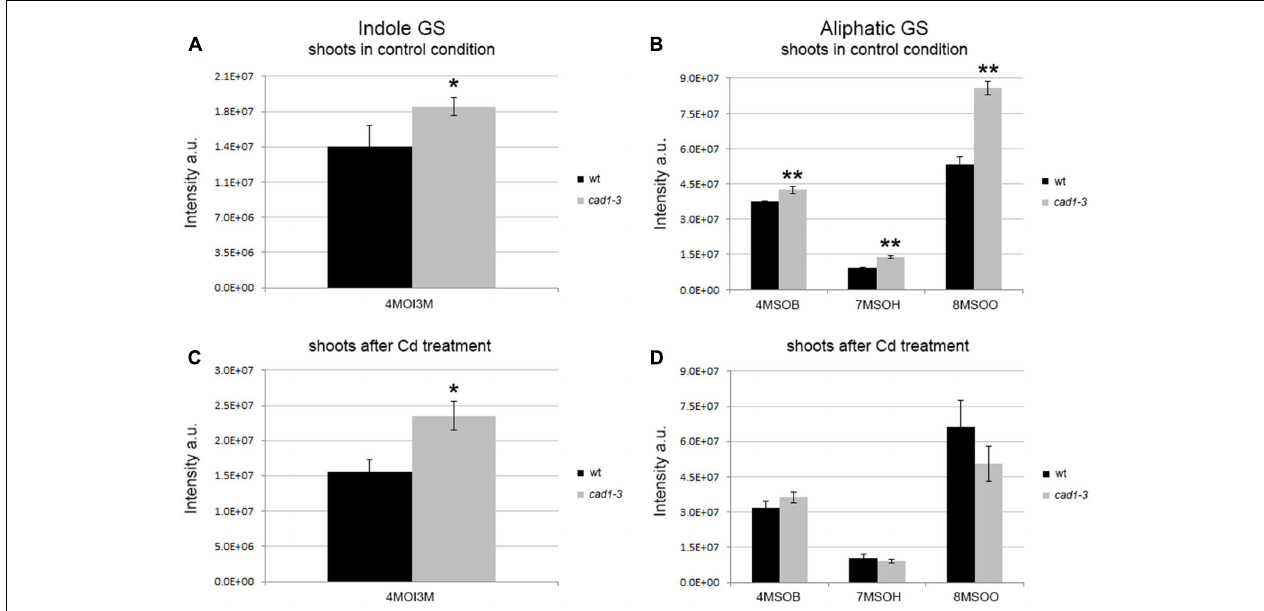
FIGURE 1 | Levels of indole and aliphatic glucosinolates in shoots from wild-type (wt) and cad1-3 plants, grown under control conditions (A,B) or exposed to 36 µ M CdCl 2 for 24 h (C,D) . 4MOI3M, 4-methoxy-indol-3-ylmethylglucosinolate; 4MSOB, 4-methylsulfinylbutylglucosinolate; 7MSOH, 7-methylsulfinylheptylglucosinolate; 8MSOO, 8-methylsulfinyloctylglucosinolate. The glucosinolate relative content is reported as ion counts (arbitrary units, a.u.). n = 5, error bars indicate SE. Statistically significant differences are calculated for each metabolite, comparing wt with cad1-3 (in the absence or presence of Cd), by means of t -student test, 2-tailed distribution. ∗ p ≤ 0.05, ∗∗ p ≤ 0.01.